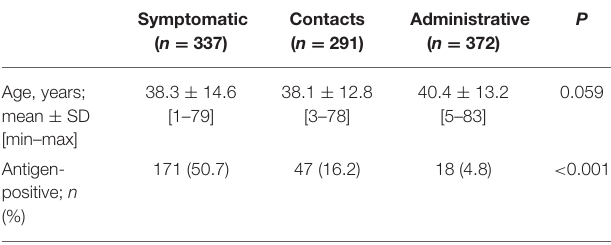
TABLE 1 | Sample breakdown according to the group, age, and antigen testing results.